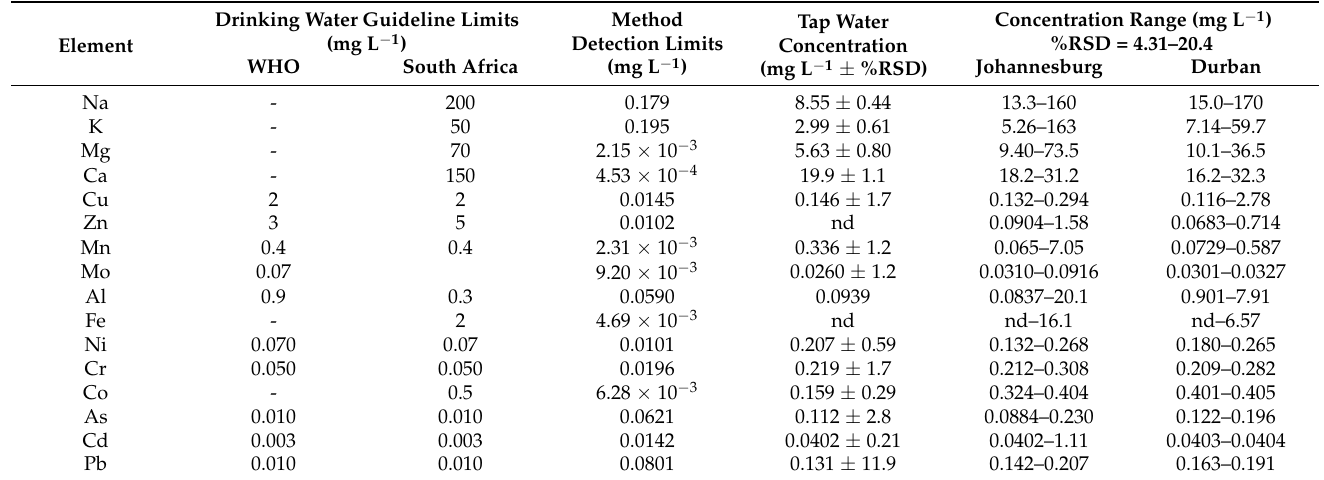
Table 1. Concentrations of metals in the aphrodisiac concoction samples.